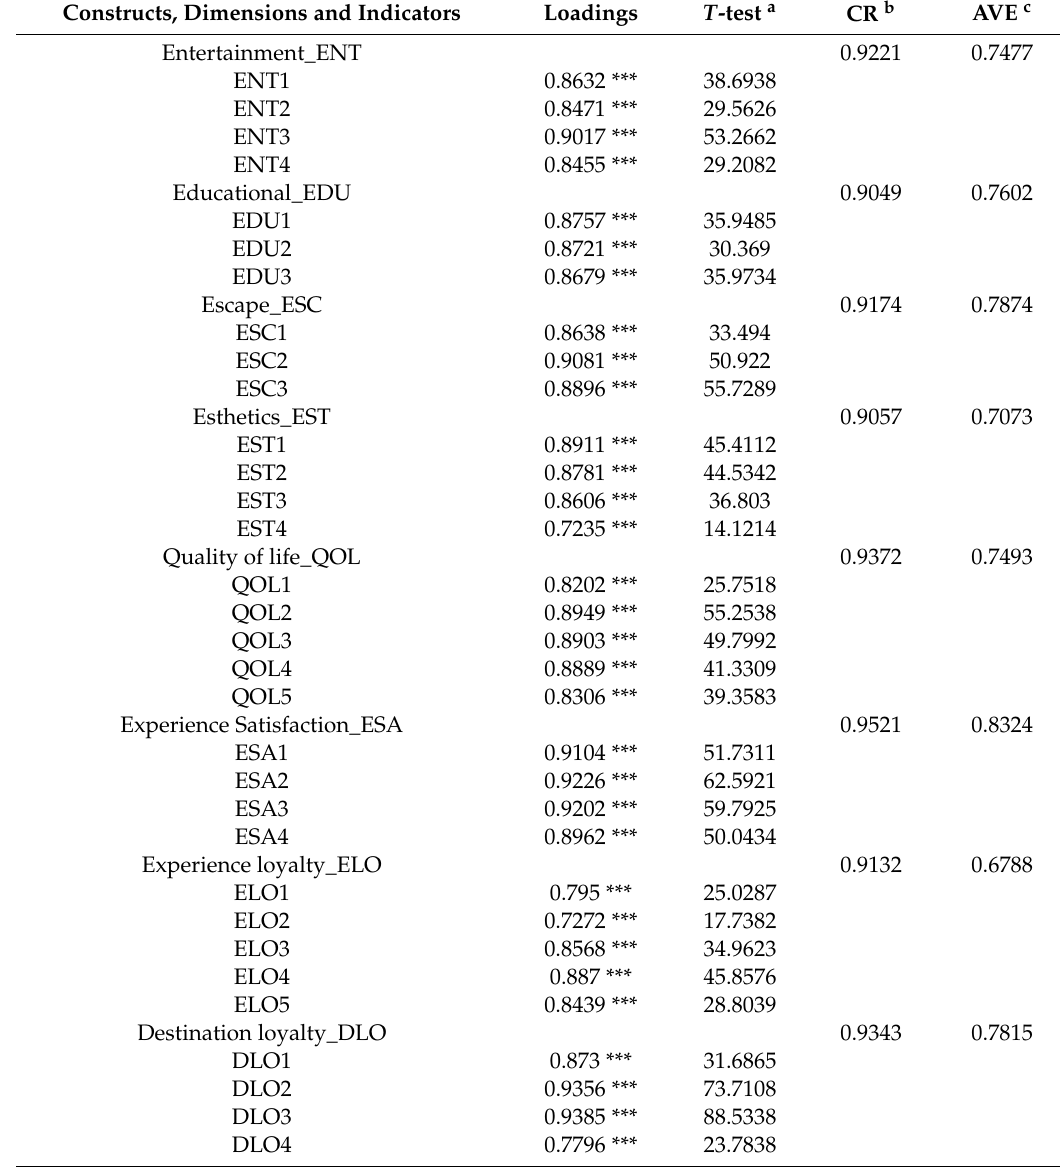
Table 4. Descriptive statistics and measurement model assessment: reflective indicators (I). Constructs, Dimensions and Indicators